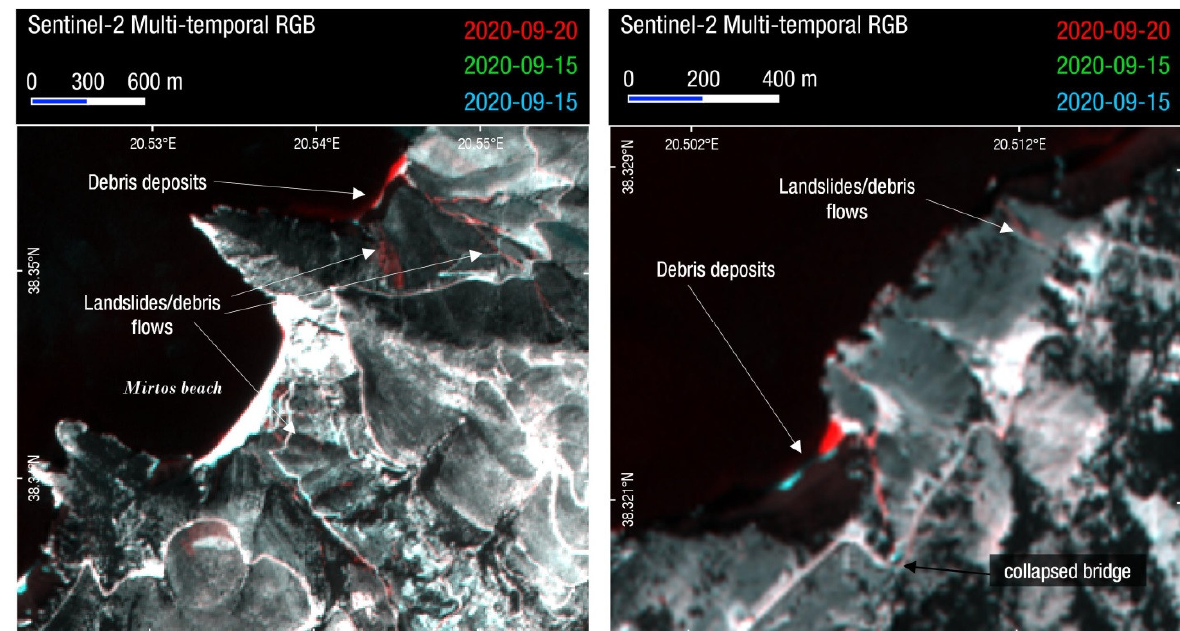
Figure 13. ( Left ): Sentinel-2 multi-temporal composite (Band 4) Fiskardo, Cephalonia. ( Right ): Sen- tinel-2 true color composite (Bands 4-3-2). Red colors mark the location of debris flows upstream of Fiskardo.